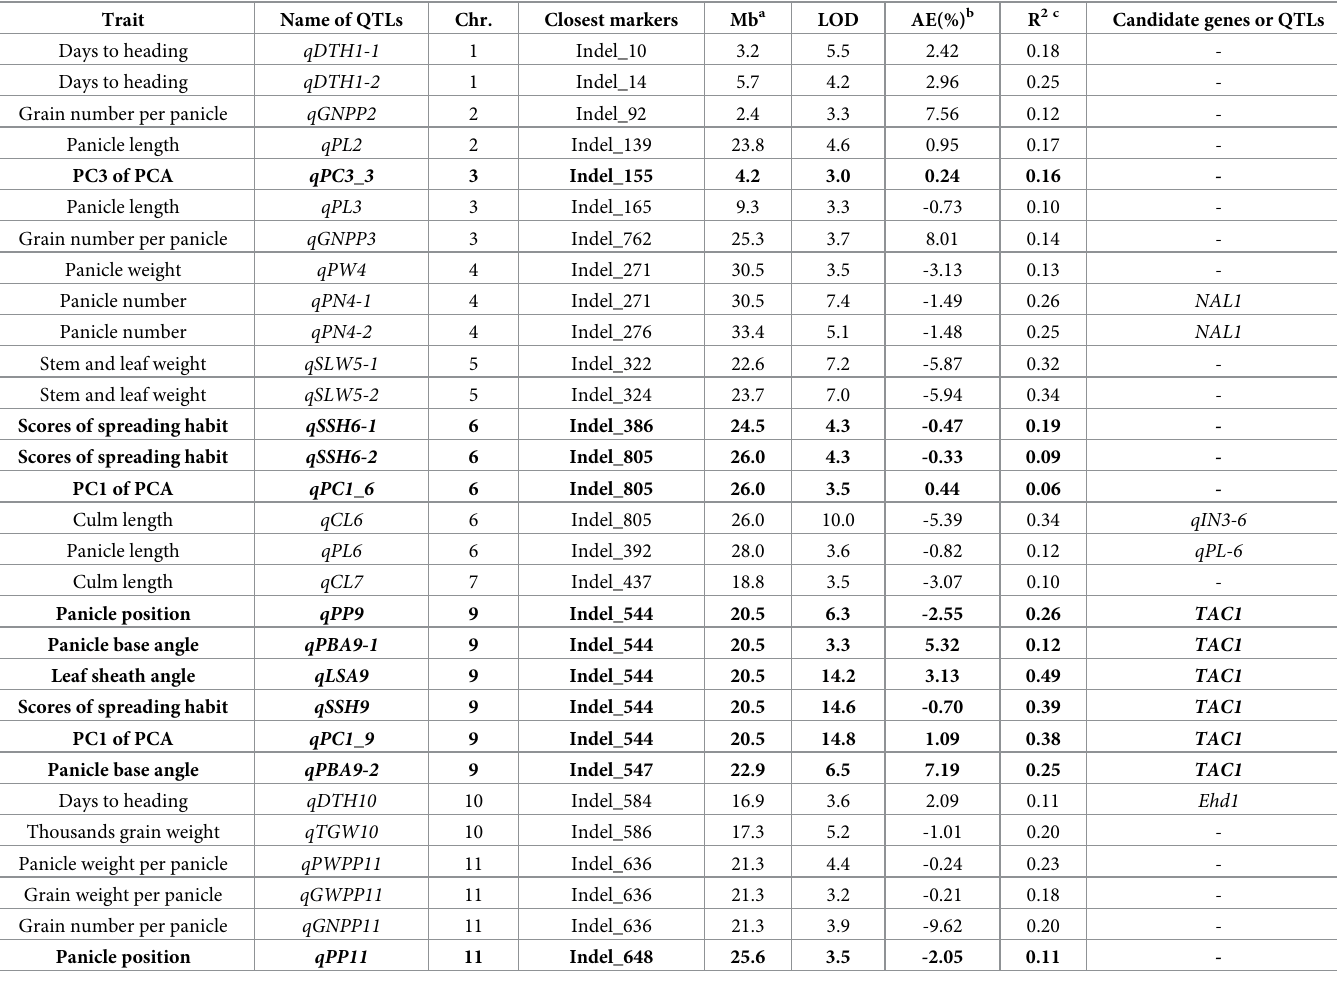
Table 1. QTL analysis of traits related to spreading habit (in bold) and yield in